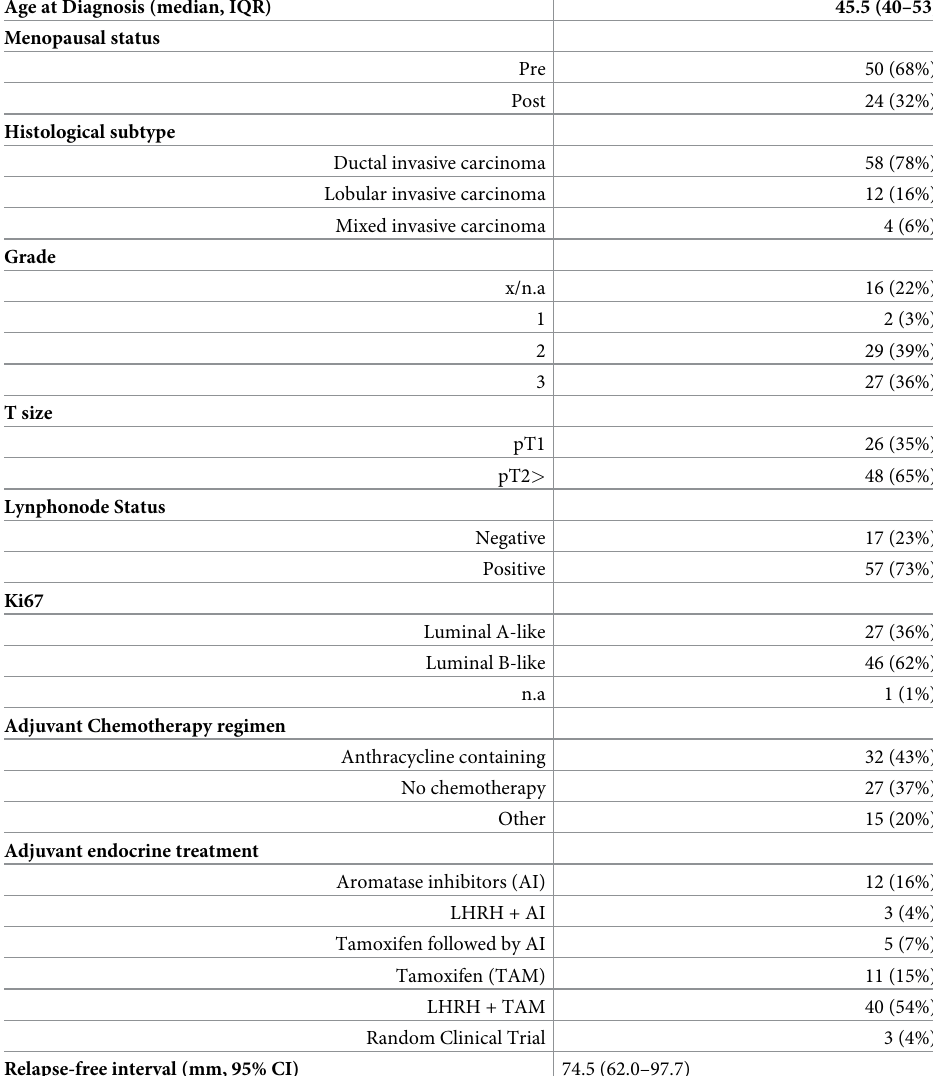
Table 1. Demographic and clinical characteristics of the study